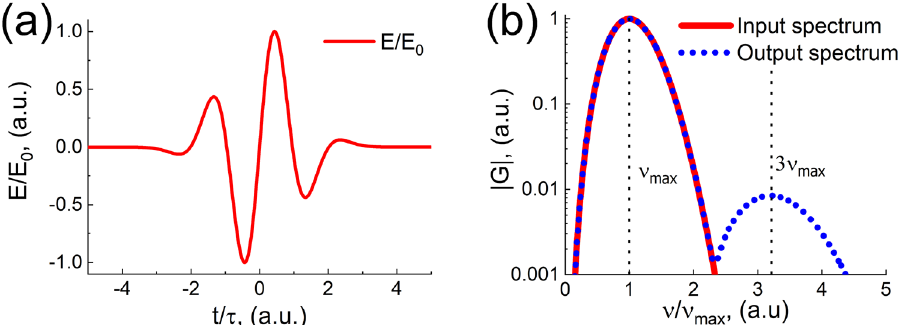
Figure 4. ( a ) Shape of the pulse with several oscillations electric field (Eq. 2). ( b ) Modulus of the pulse spectrum at the input of the medium (the red curve, Eq. 10) and the spectrum of the pulse at the output of the medium (the blue dotted curve, Eq. 9). The position of the maximum frequency ν max of the THz radiation is